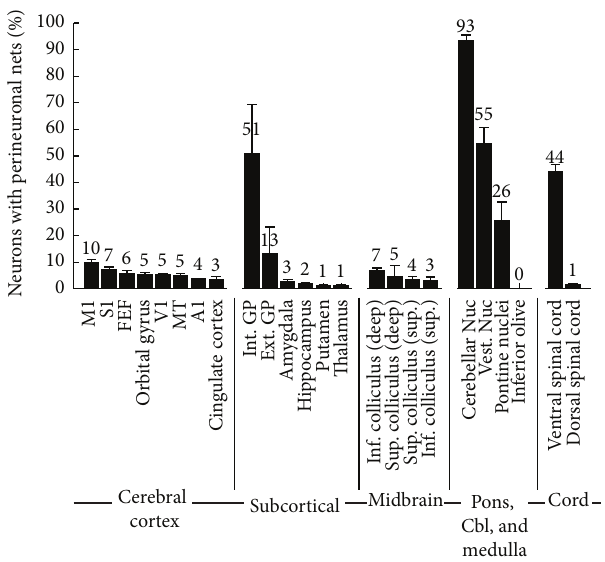
Figure3:Percentageofneuronssurroundedbyperineuronalnetsin different parts of the brain. Each bar represents the mean percentage of neurons that were surrounded by perineuronal nets in one part of the brain. The values, rounded to the nearest percentage, are shown above each bar. Averages and standard error are calculated from at least 4 monkeys for each